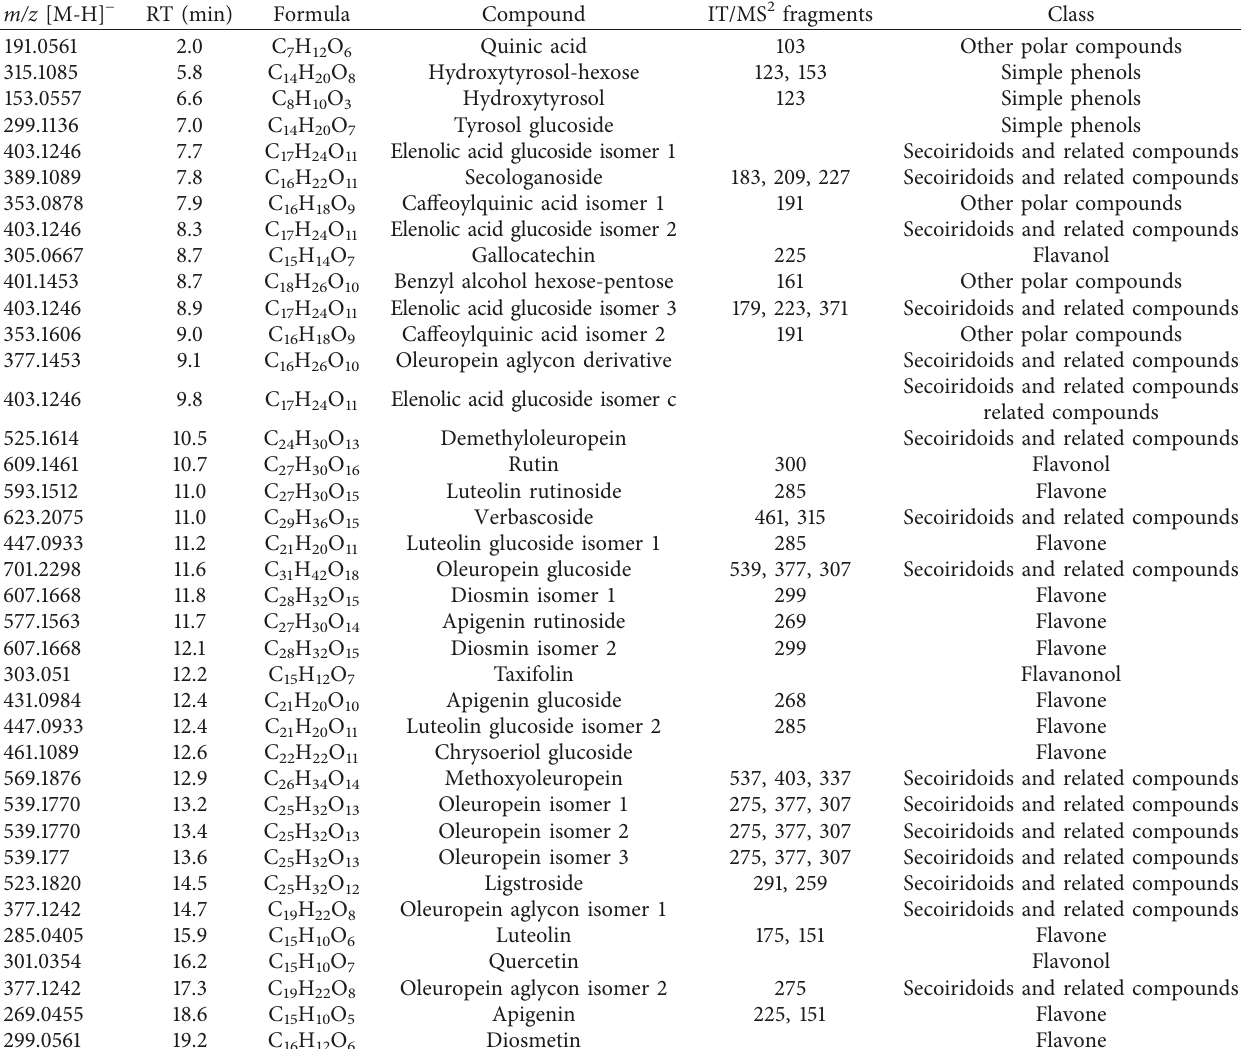
Table 1: Identification data for the compounds detected in olive leaf